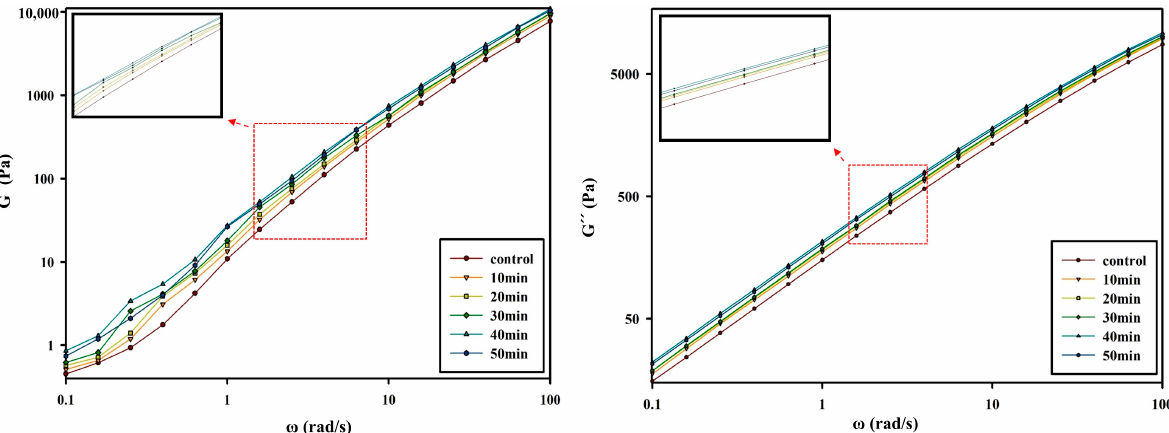
Figure 6. Storage modulus and loss modulus of PBSeT samples that were SSP processed at 90 °C for different periods of time. The data were acquired at T = 120 °C. different periods of time. The data were acquired at T = 120 ◦